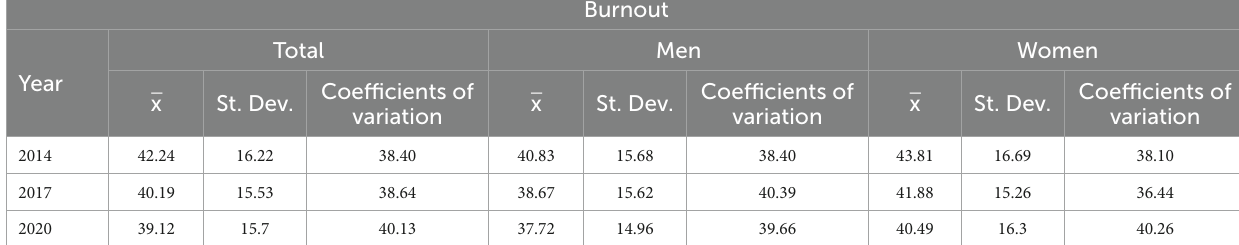
TABLE 3 Burnout